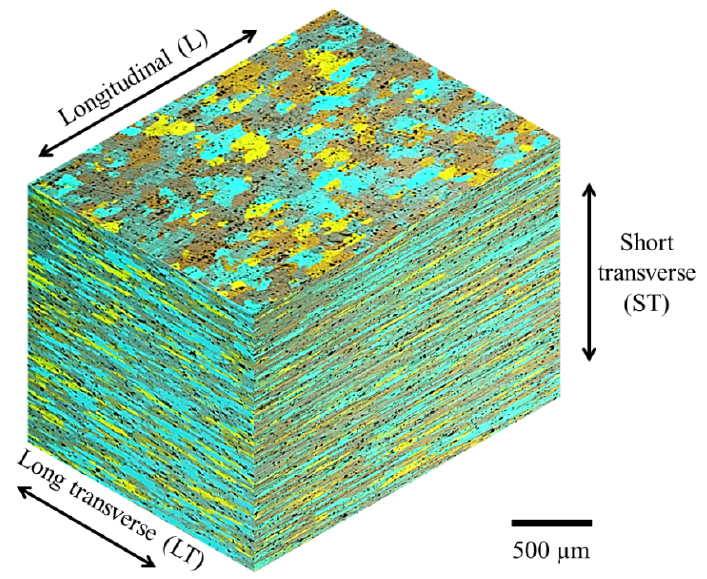
Figure 4. Grain structure of the 7075-T651 aluminum alloy.